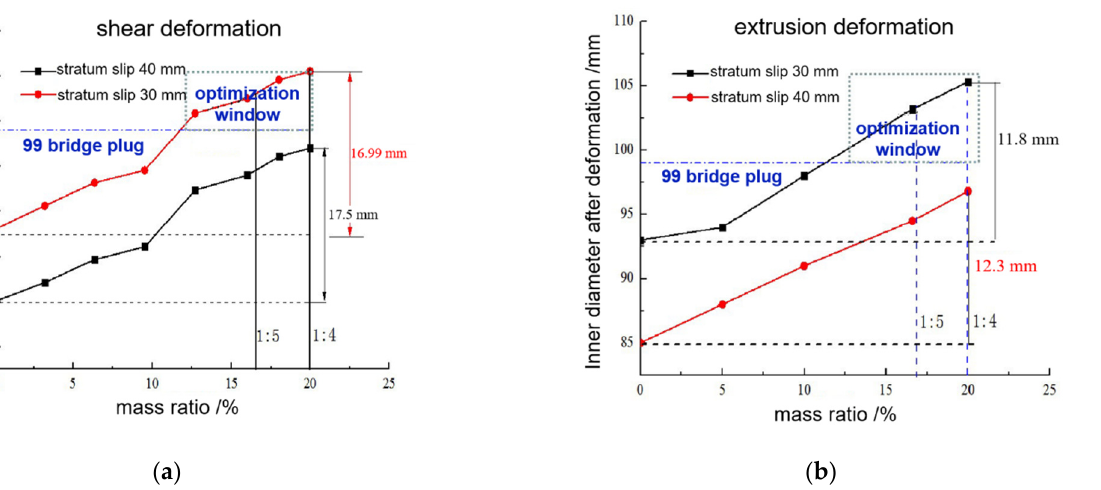
Figure 20. Process optimization window of modified cement sheath: ( a ) shear deformation; ( b ) extrusion deformation.